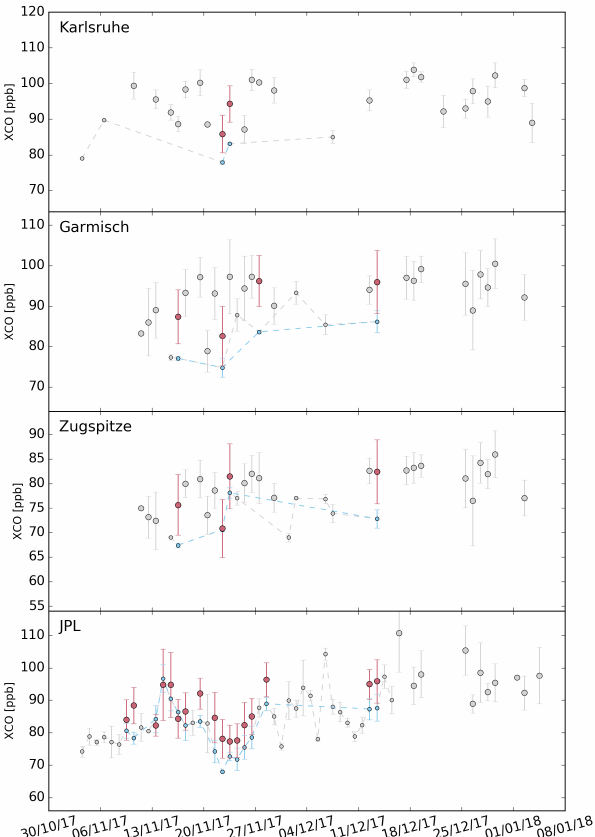
Figure 3. Daily means of dry air column mixing ratios (XCO) mea- sured by TROPOMI (pink) and various TCCON stations (blue). A co-location radius of 50km is used. The standard deviation of indi- vidual retrievals within a day is shown as an error bar. Data points without time coincidence between TCCON and TROPOMI are plot- ted in grey. No de-striping was applied on the TROPOMI